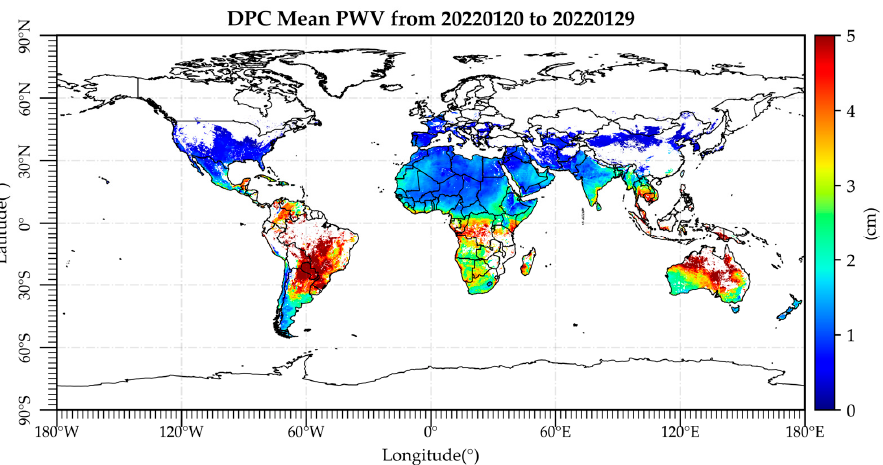
Figure 3. Global mean PWV values derived from DPC data for 20 January 2022 and 29 January 2022.